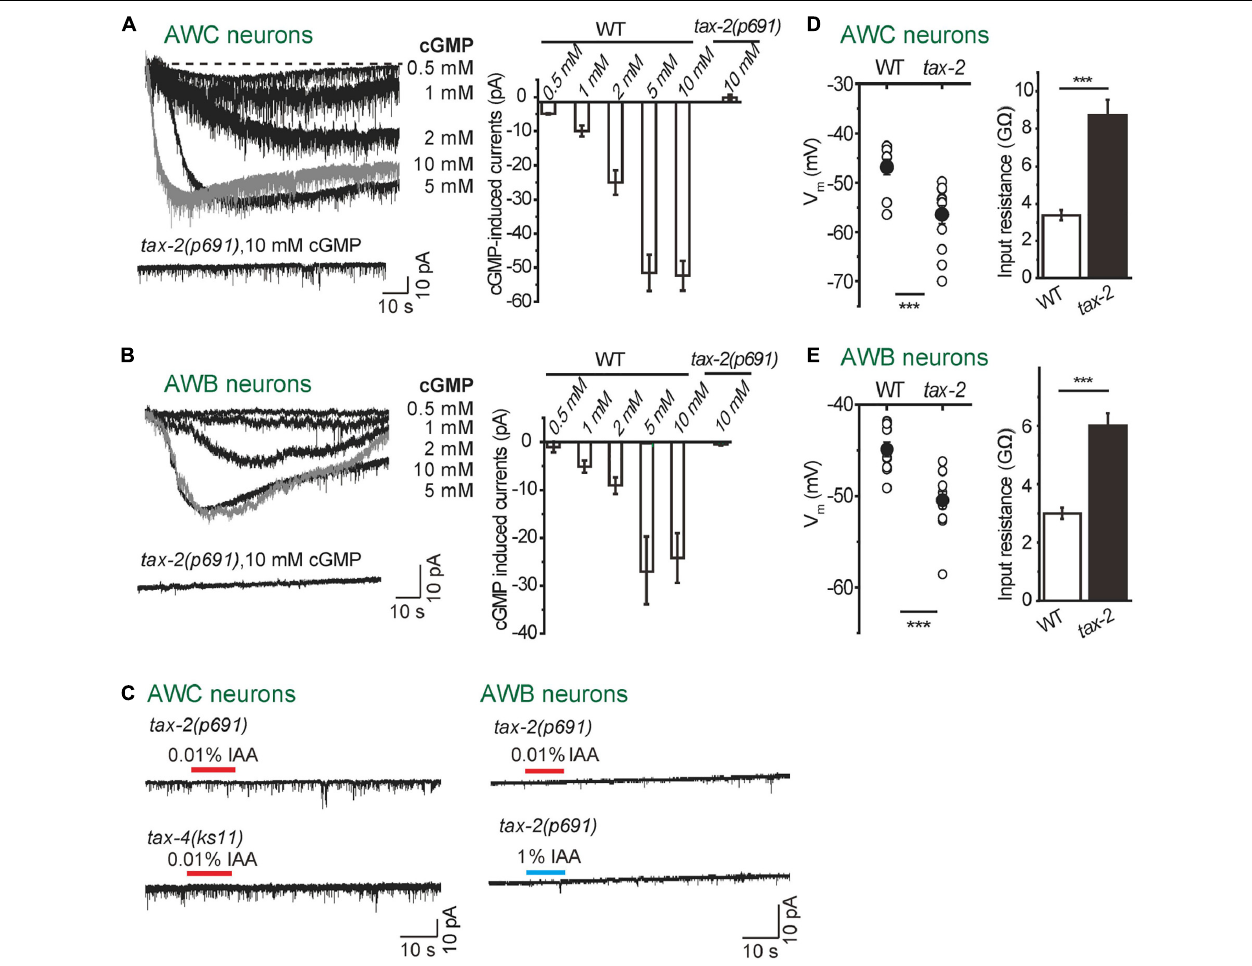
FIGURE 2 | TAX-2/TAX-4 channel is critical for intensity-dependent olfactory encoding. (A,B) Dialyzing cGMP into AWC and AWB neurons with the recording pipette induced inward currents in wild-type worms, but not in tax-2(p691) mutants. (A) AWC neurons. (B) AWB neurons. The cell membrane potential was voltage-clamped at –70 mV. n ≥ 5. (C) No IAA-induced current was recorded in either tax-2(p691) or tax-4(ks11) mutants from AWC and AWB neurons. (Right) AWC neurons. (Left) AWB neurons. The cell membrane potential was voltage-clamped at –70 mV. n ≥ 6. (D,E) Membrane potentials of AWC neurons (D) and AWB neurons (E) were hyperpolarized and input resistances were increased in tax-2(p691) mutants. –10 mV voltage step was injected into AWC and AWB and the input resistance was calculated by –10 mV divided by the recorded currents. n ≥ 7. Error bars: SEM. *** P < 0.001.